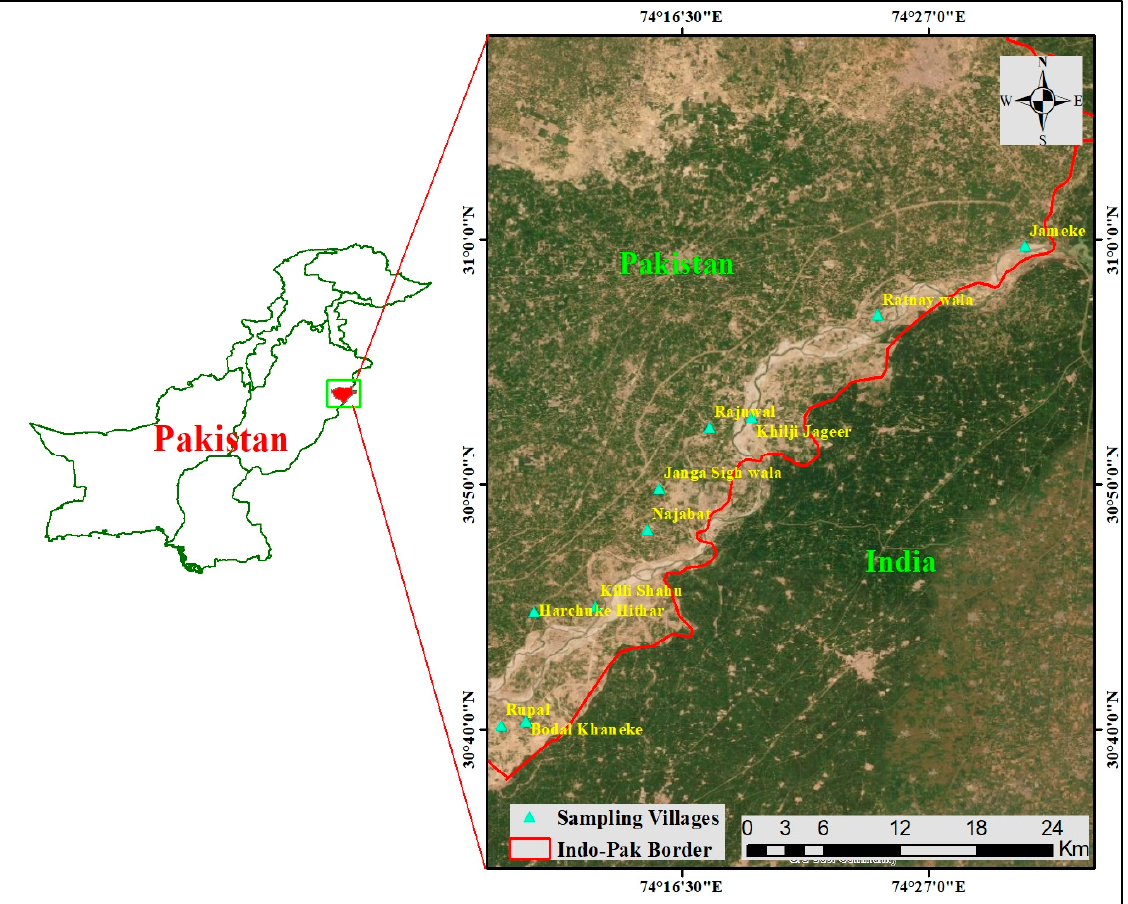
Figure 1. A map showing the location of the study communities from Pakistan’s semi-arid region.